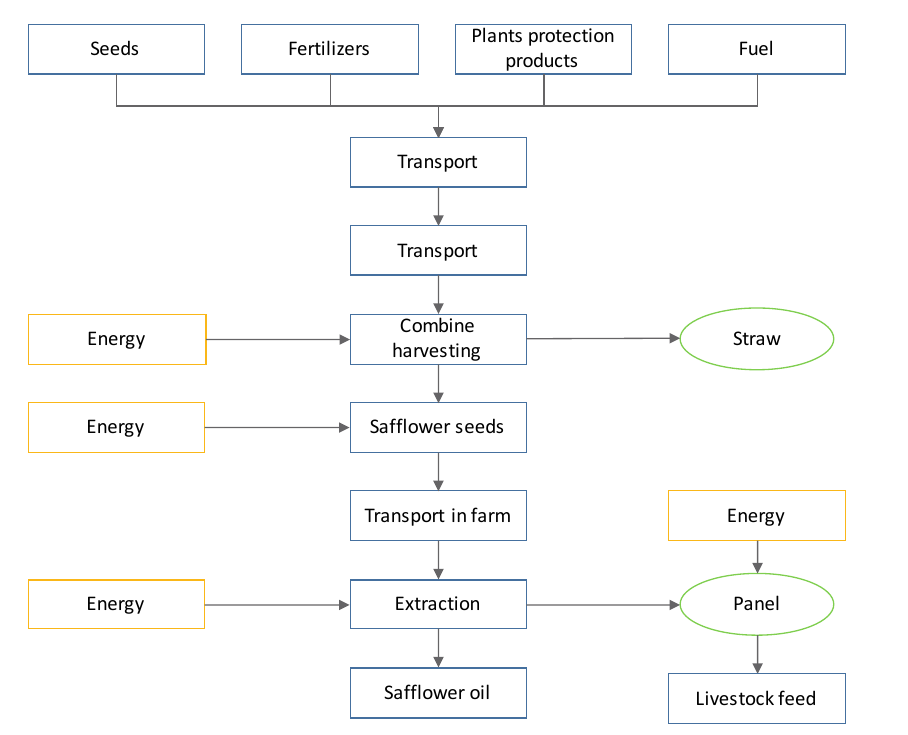
Fig. 1. System Boundaries of safflower oil